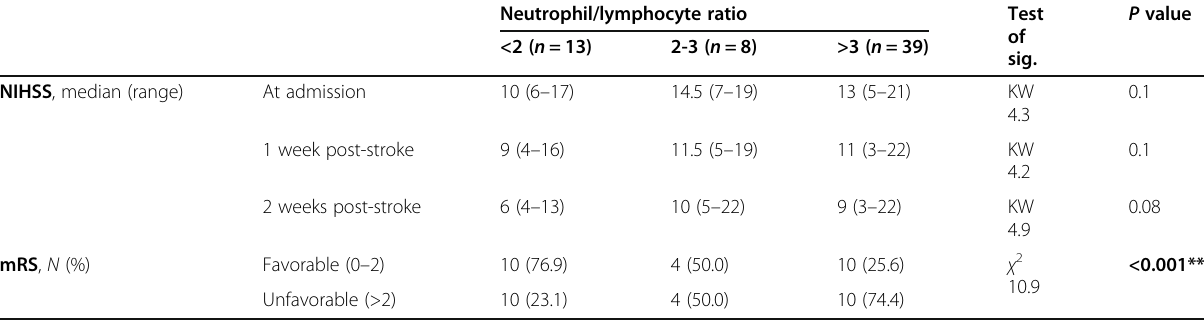
Table 2 Association between neutrophil/lymphocyte ratio, National Institute of Health Stroke Scale (NIHSS), and Modified Rankin Scale (mRS) among the studied